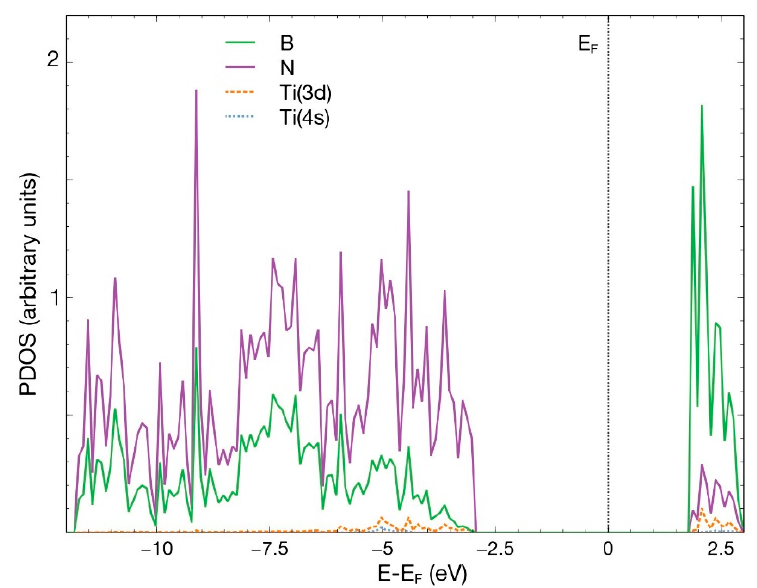
Figure 5. PDOS for the titanium atom absorbed in a B vacancy site on the hBN surface. This figure shows the p orbitals for boron and nitrogen and the s and d orbitals for Ti.